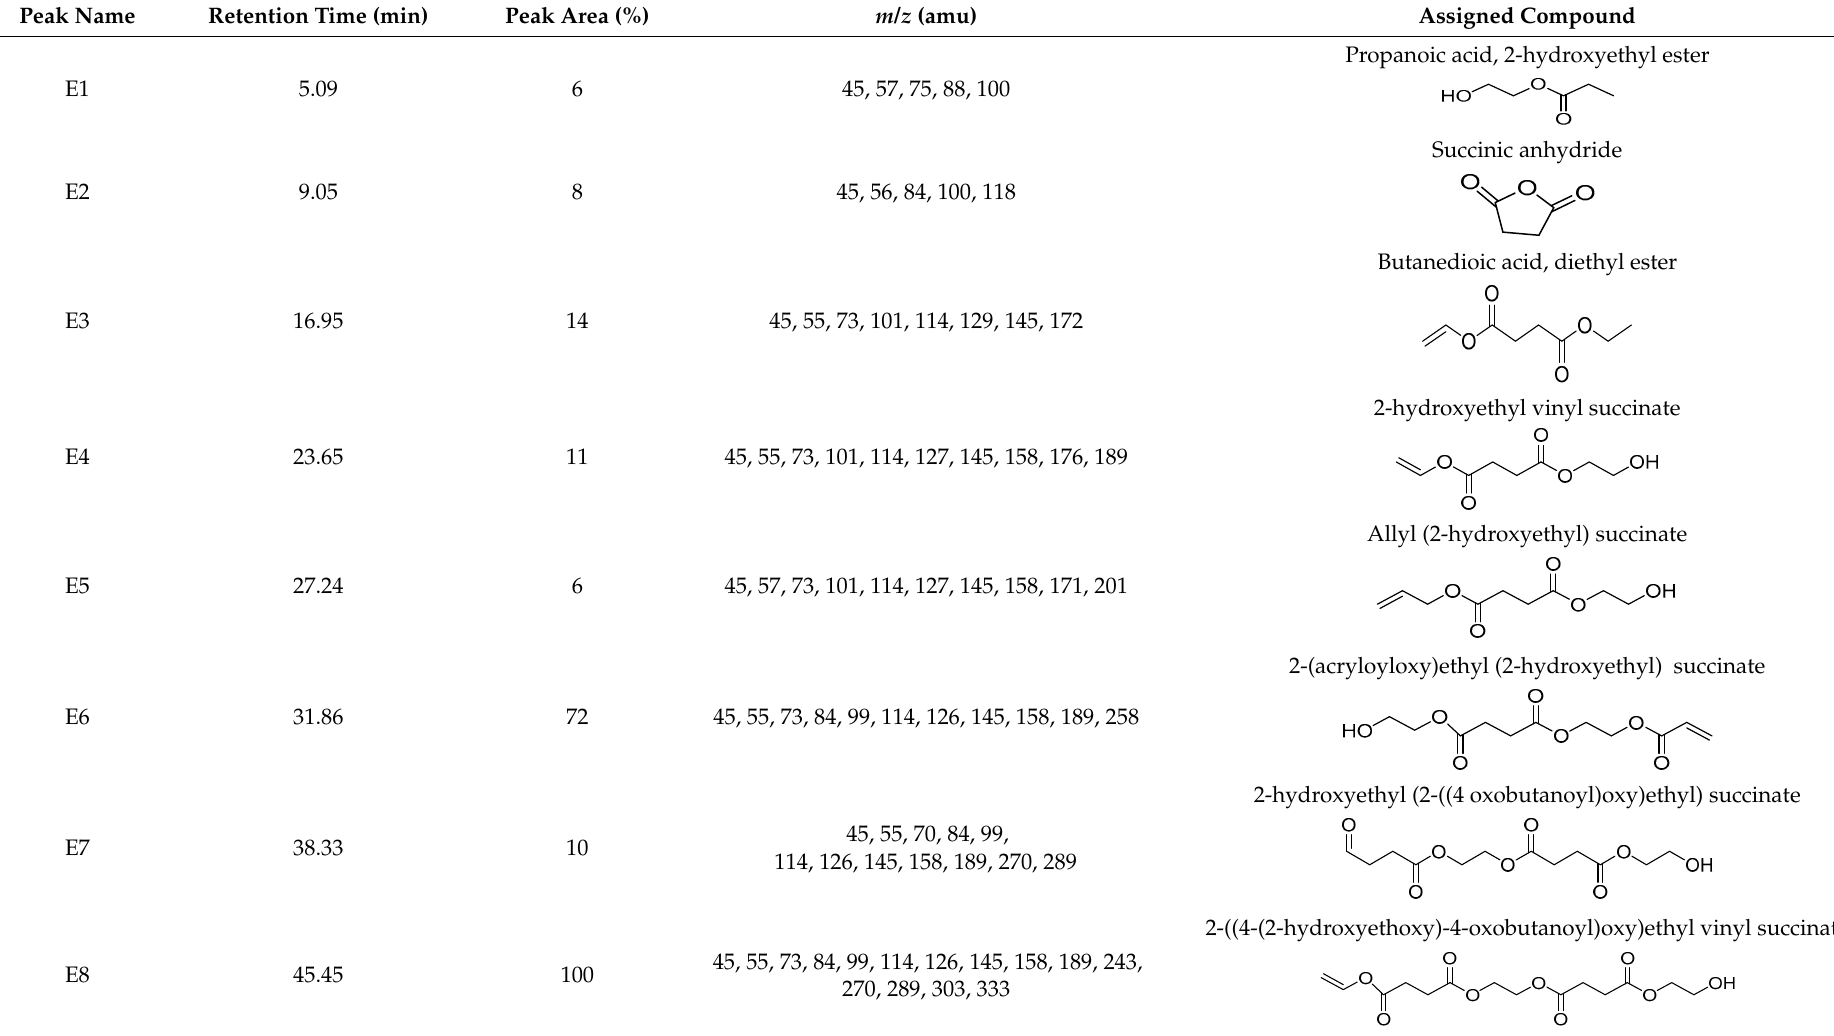
Table 3. Thermal decomposition products of PESu.